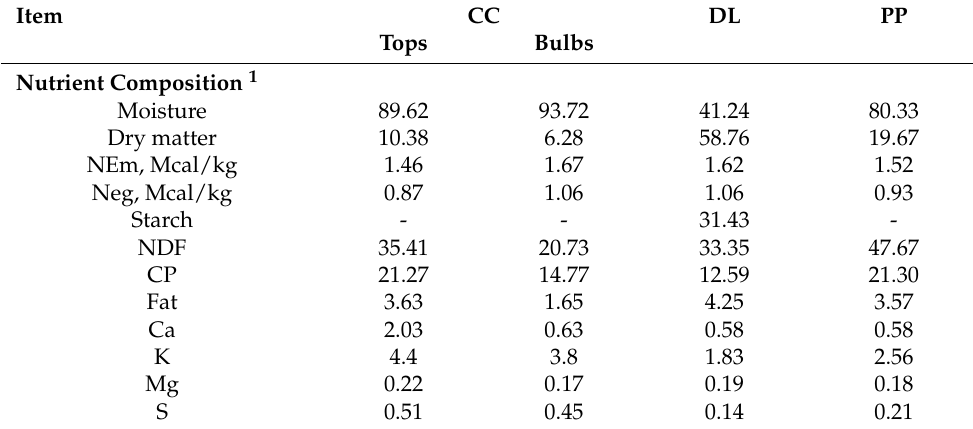
Table 1. Nutrient composition is the backgrounding